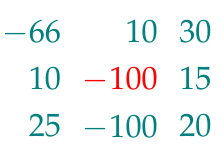
values Figure 3. The sample 2D data grid. The for the product V are displayed.